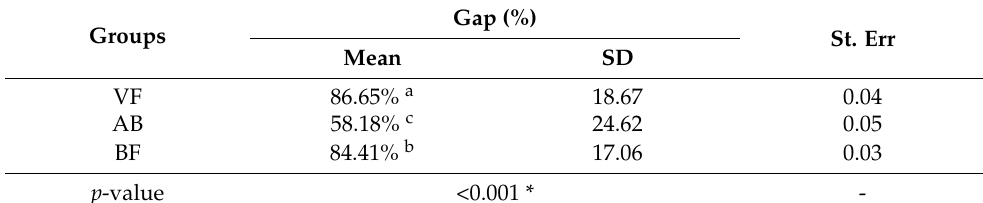
Table 3. Summary of the internal cavity floor gap percentage of the tested groups (mean ± standard